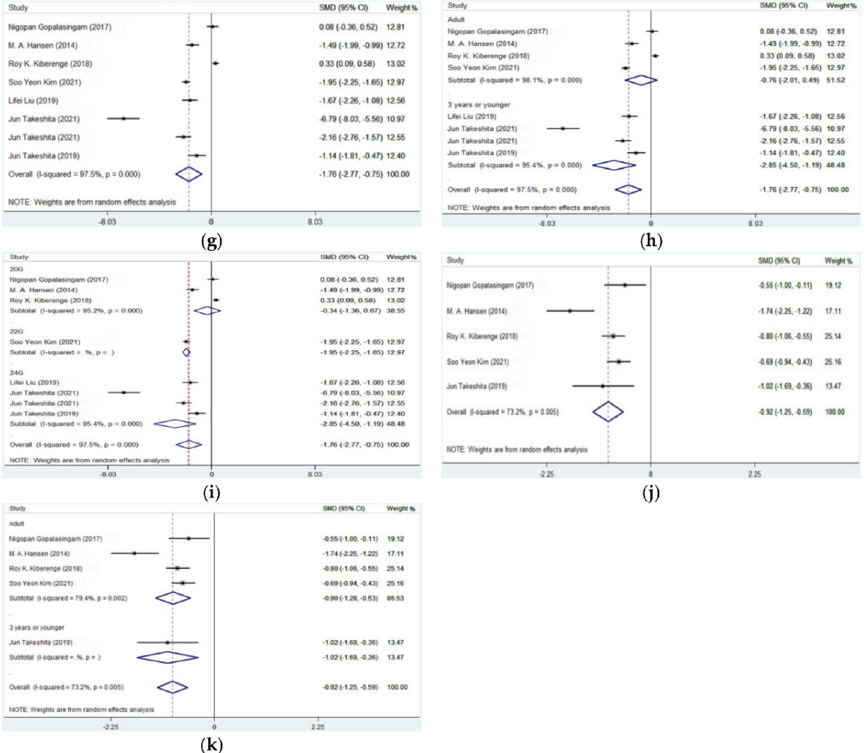
Figure 3. Forest plots for the efficiency outcomes of artery catheterization guided by DNTP vs. palpation approach [7,8,11–15]. ( a ) First-attempt success of DNTP vs. palpation; ( b ) subgroup analysis by patient age in first-attempt success of DNTP vs. palpation; ( c ) subgroup analysis by catheter size in first-attempt success of DNTP vs. palpation; ( d ) overall success of DNTP vs. palpation; ( e ) subgroup analysis by patient age in overall success of DNTP vs. palpation; ( f ) subgroup analysis by catheter size in overall attempt success of DNTP vs. palpation; ( g ) cannulation time of DNTP vs. palpation; ( h ) subgroup analysis by patient age in cannulation time of DNTP vs. palpation; ( i ) subgroup analysis by catheter size in cannulation time of DNTP vs. palpation; ( j ) puncture number of DNTP vs. palpation; ( k ) subgroup analysis by patient age in puncture number of DNTP vs. palpation.